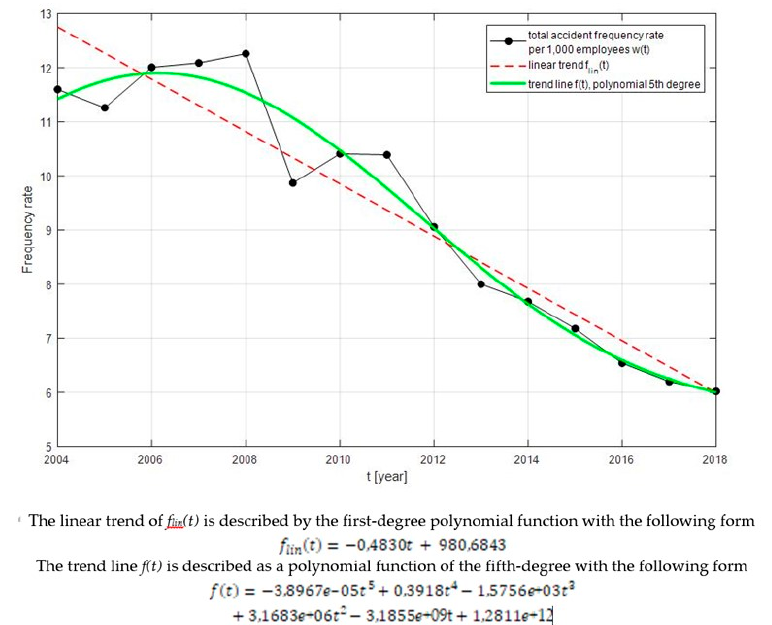
Figure 5. Trends of changes in the ratio of the index of the indicator of frequency of total accidents in civil engineering.